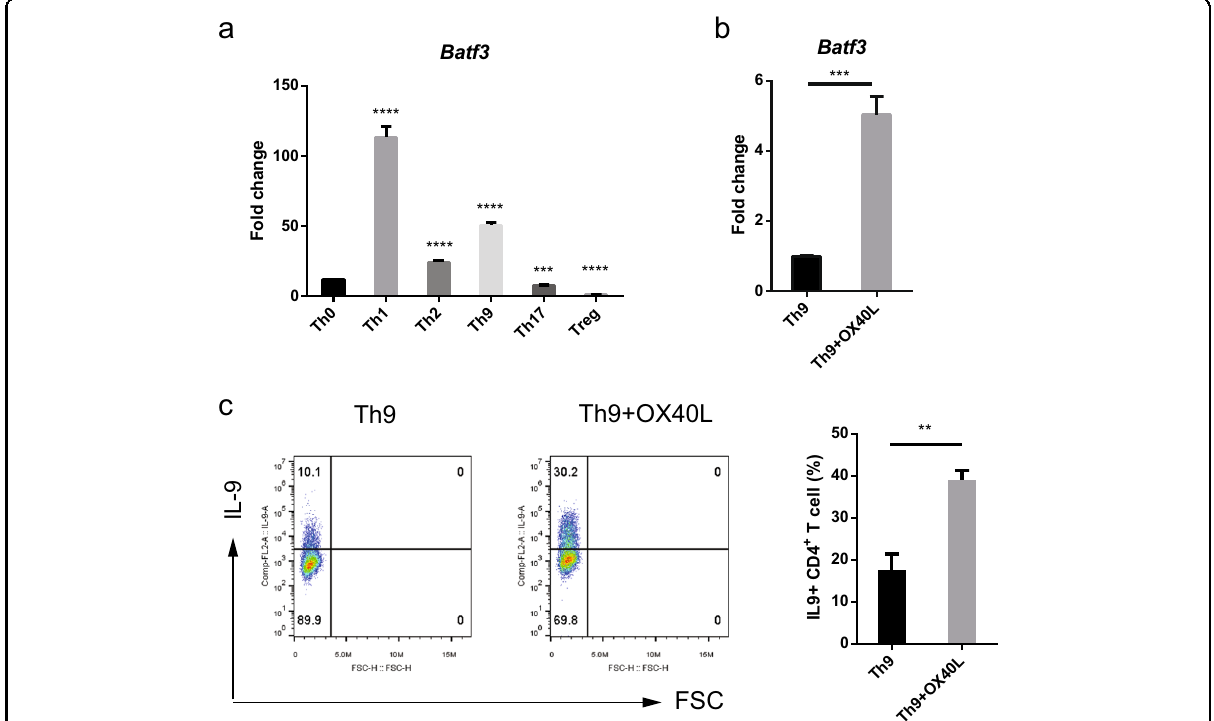
Fig. 1 Batf3 expression in Th9 cells increases signi fi cantly upon exposure to OX40L. a Expression of Batf3 messenger RNA (mRNA) in cells stimulated under Th0, Th1, Th2, Th9, Th17, and Treg conditions was measured by qRT-PCR. Data were normalized to Gapdh expression and are shown relative to Th0 conditions. Statistical analyses were performed by comparing Th0 with each subset. b Expression of Batf3 mRNA in cells stimulated under Th9 or Th9 + OX40L conditions (with OX40L under Th9 conditions) was measured by qRT-PCR. Data were normalized to those of Gapdh and relative to Th9 conditions. c Naive CD4 + T cells were cultured for 3 days under Th9 or Th9 + OX40L conditions, and the percentage of IL-9 + CD4 + T cells was measured by fl ow cytometry. Left: data are representative of three independent experiments. Right: data are expressed as the mean of three independent experiments. The error bars represent the s.d. P values were calculated using Student ’ s t -tests. * P < 0.05, ** P < 0.01, *** P < 0.001, and **** P <